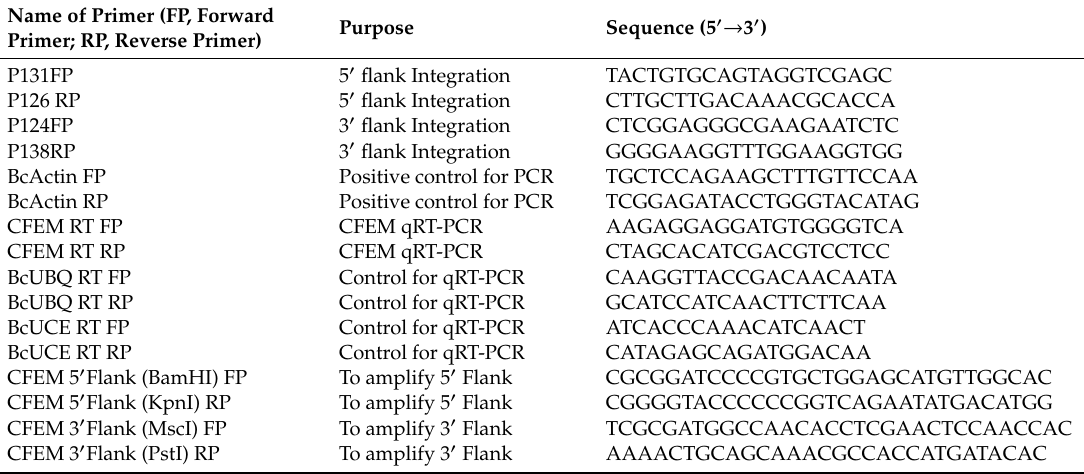
Table 2. Primers used in the